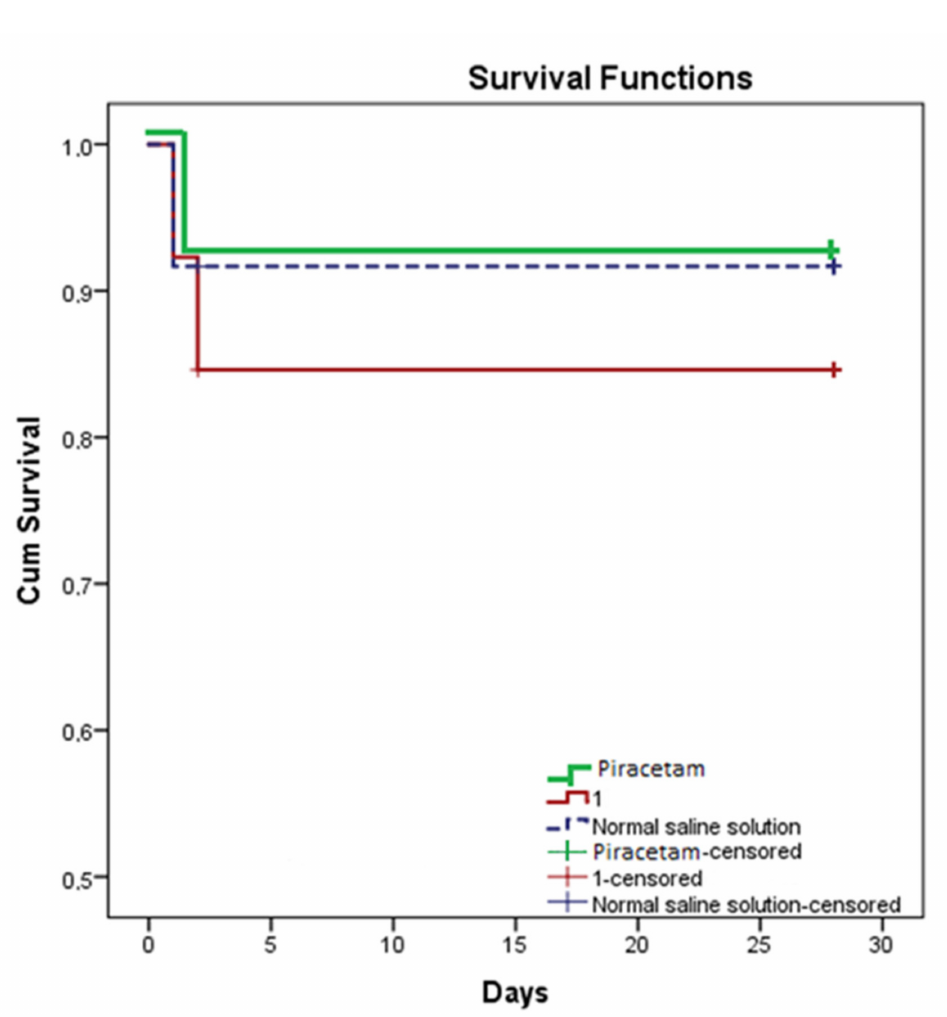
Figure 2. Kaplan–Meier survival curves for rats of the group with compound 1 administration (red line), piracetam (green line), and normal saline solution (blue line) within 28 days of observation. No significant differences between groups of animals were